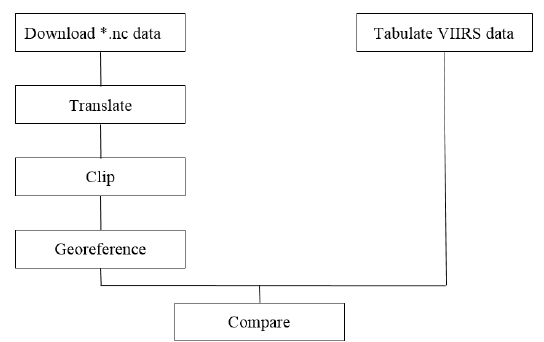
Figure 3 . Flowchart of the techniques and methods used in processing of FY-4A and VIIRS